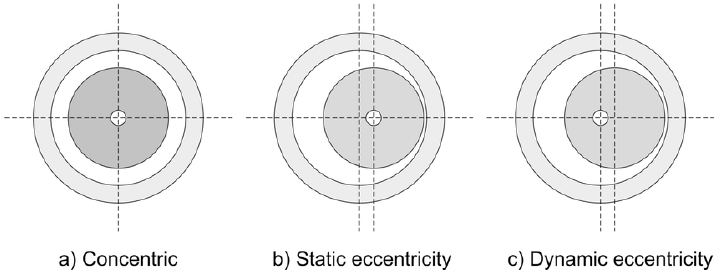
Figure 3. Examples of a machine: without eccentricity ( a ); static eccentricity ( b ); and dynamic eccentricity ( c